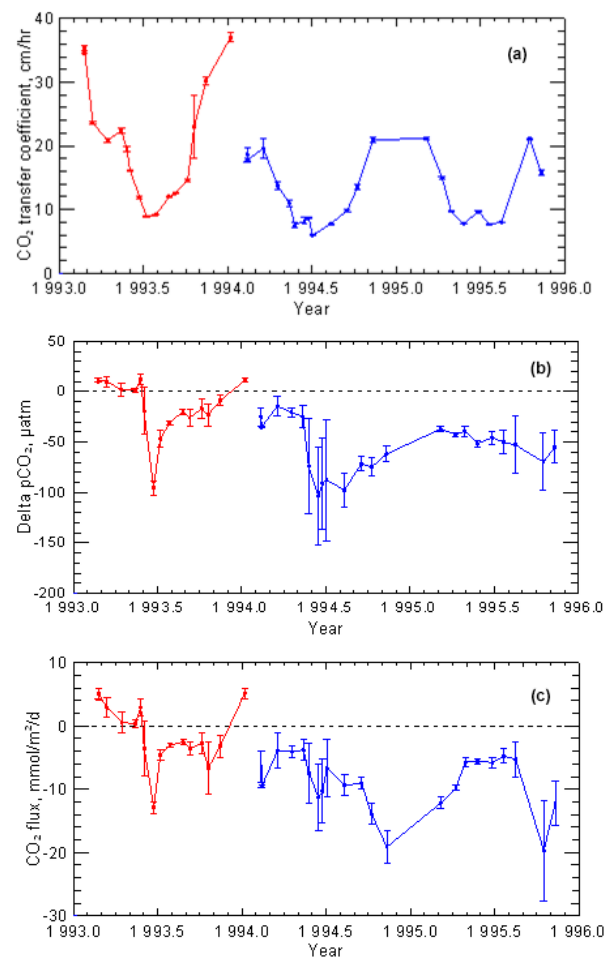
Figure 3. Seasonal variations in the Atlantic Water of the Irminger Sea (red) and in the Arctic Water of the Iceland Sea (blue). The gas transfer velocity (a) reflects the seasonal wind strength and the er- ror bars its variations during intervals between cruises. Delta p CO 2 (b) records the tendency for CO 2 to be transferred to the atmosphere (positive) or from the atmosphere to the ocean (negative). The CO 2 flux rate (c) reveals that the Arctic Water is a CO 2 sink in all sea- sons, whereas the Atlantic Water is a source in winter and a weak sink at other times of the year. The error bars indicate ± 1 standard deviation from the mean and reflect the variations between the sta- tions observed each